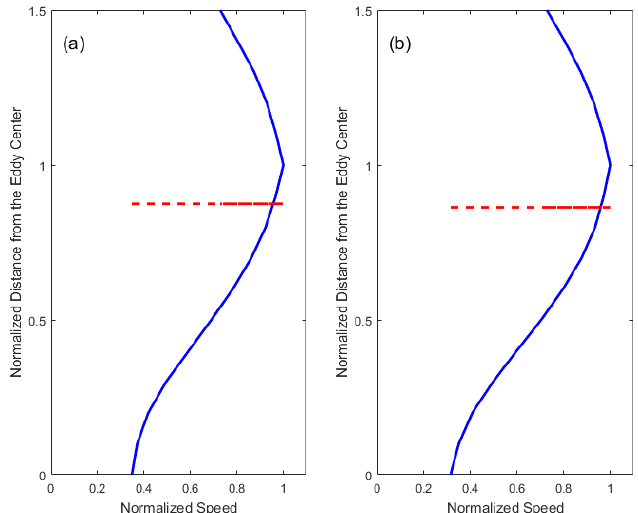
Figure 7. The radial mean profile of current speed from the eddy center towards filament. The speed and the distance are normalized by the magnitude and radial distance at the location of maximum-speed of an eddy respectively: ( a ) anticyclonic case; ( b ) cyclonic case. Red dashed line marks the mean position where filaments